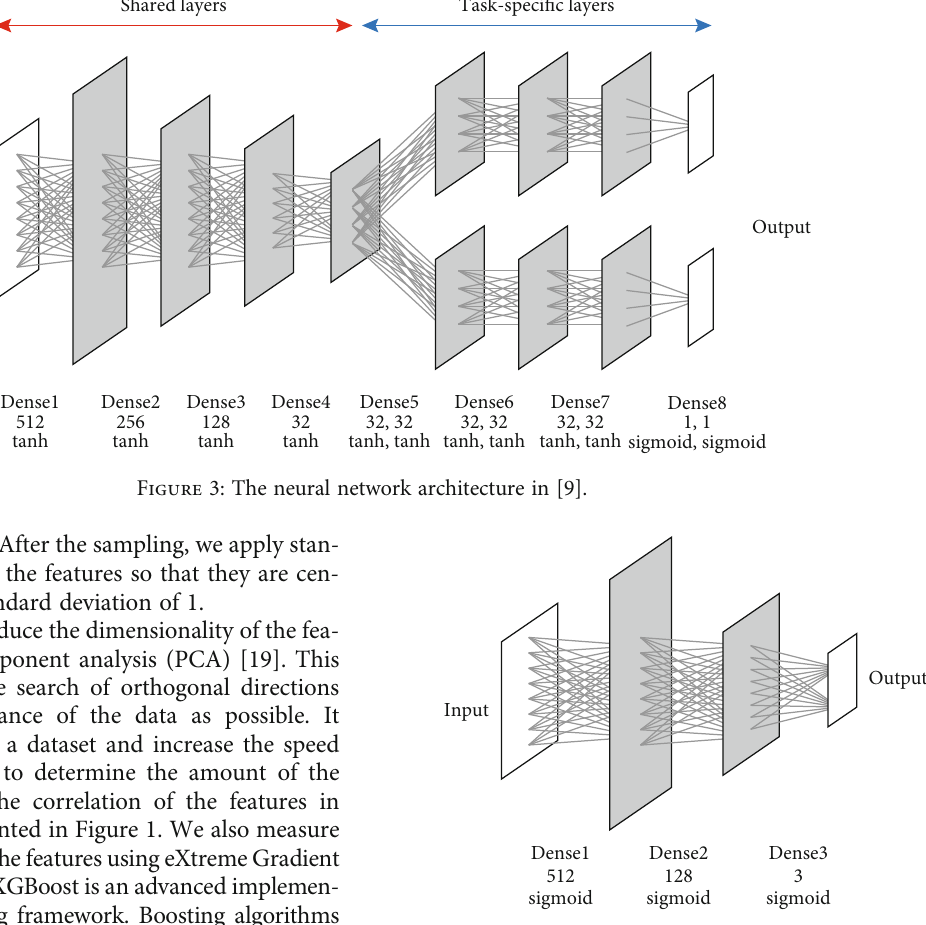
Figure 4: The proposed neural network